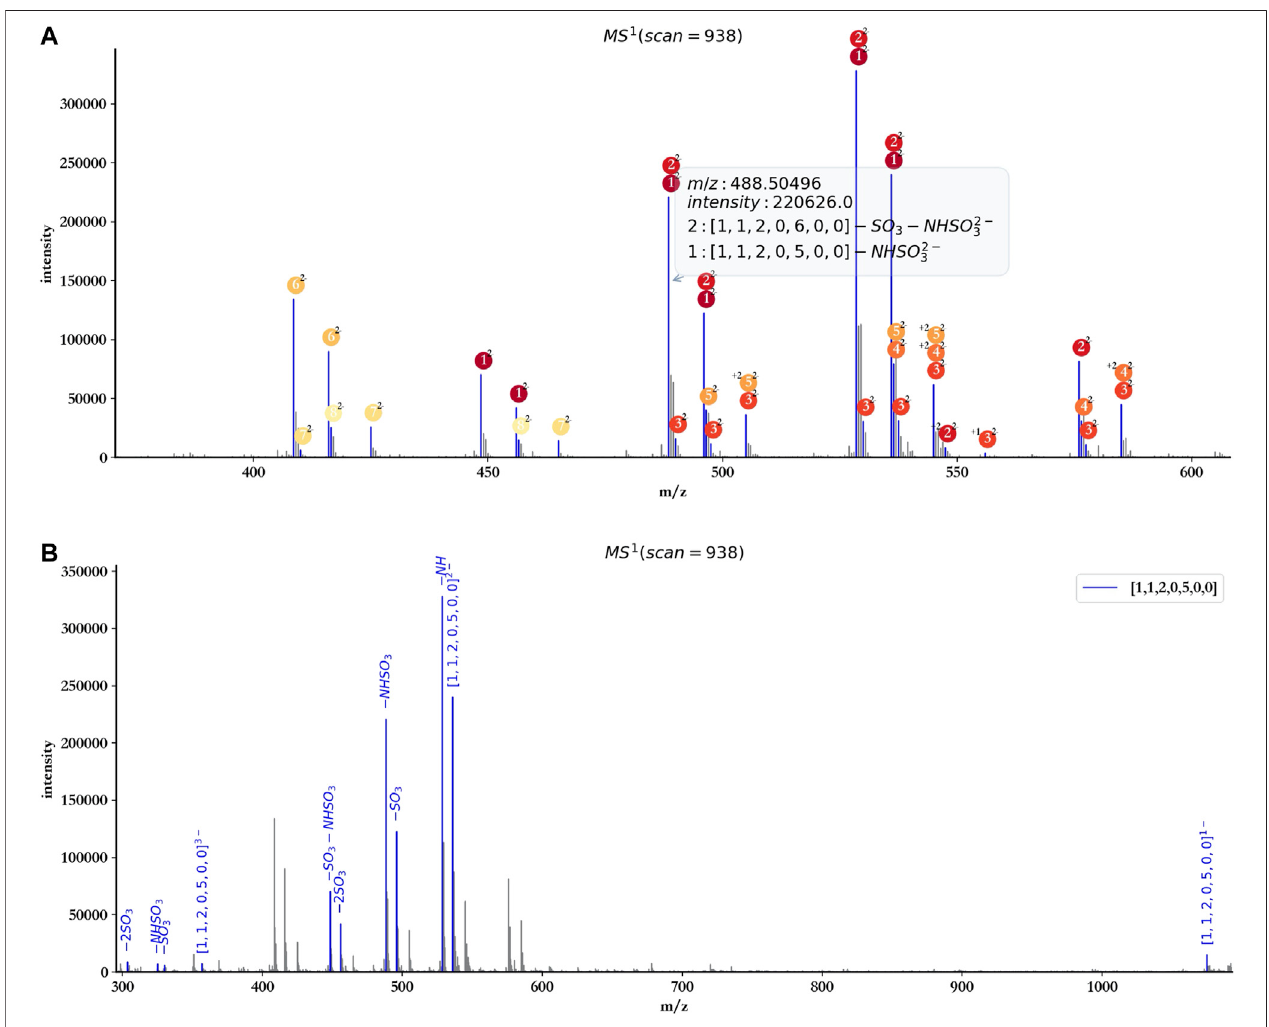
FIGURE 6 | Tips window example (A) and annotation with a single component ([1, 1, 2, 0, 5, 0, 0]) of dp4 oligosaccharides (B) .